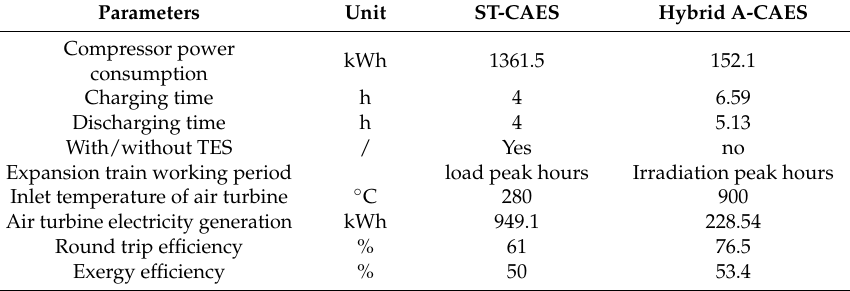
Table 7. The comparison of performance of ST-CAES to hybrid A-CAES.